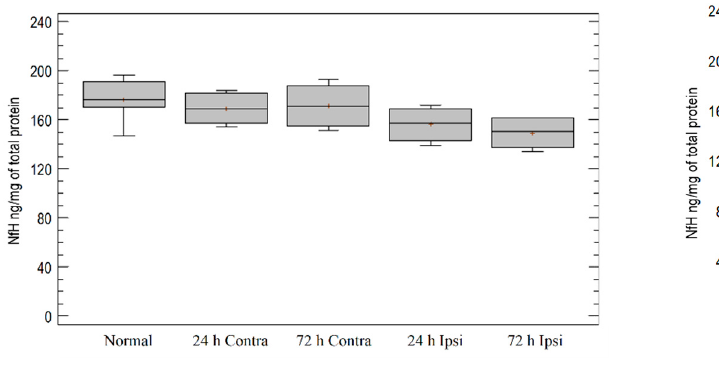
Figure 6. CXCL12 expression in mouse brain after ( A ) PBS injection and ( B ) KA injection. Brains were collected 24 h and 72 h postinjection. Ipsi—ipsilateral hemisphere; Contra—contralateral hem- isphere; Normal—control animals without any injection.